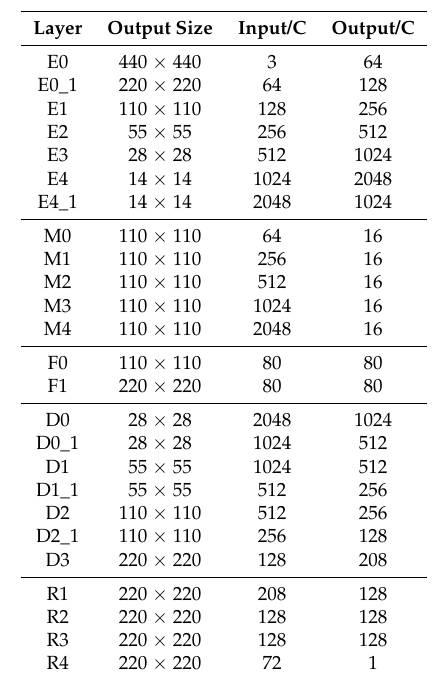
Figure 7. From left to right : aerial image, CNN features from Multi-feature block and CNN features from first layer of encoding block. Table 1. IM2ELEVATION size of feature maps, and input/output channel based on SENet